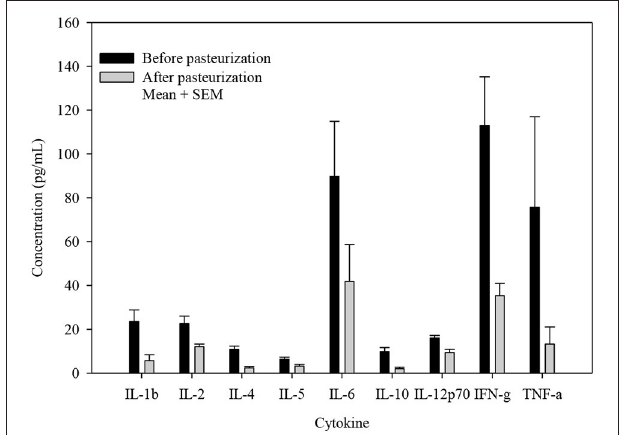
FIGURE 1 | Cytokine concentrations before and after pasteurization. The concentration of cytokines of 24 milk samples measured in duplicates in thawed human milk before and after pasteurization. All cytokine concentrations decreased significantly, p ≤